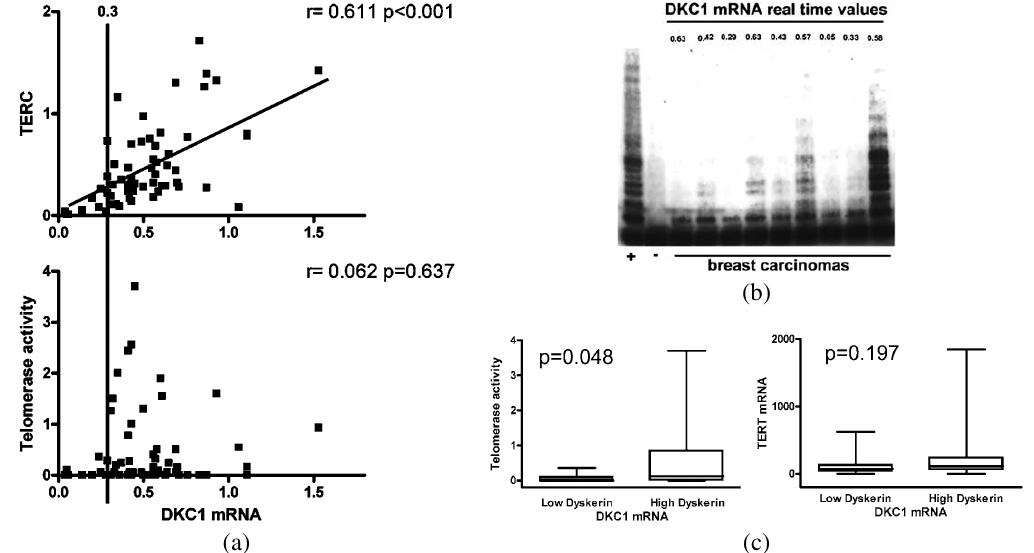
Fig. 1. Relationship between dyskerin expression and TERC, TERT and telomerase activity in breast carcinomas. Dyskerin mRNA levels proved strictly related to TERC levels (a, upper panel). No linear relationship was found when comparing dyskerin mRNA expression and telomerase activity, though a subset of tumours characterized by reduced dyskerin expression (relative expression < 0.3) were characterized by a significant reduction in telomerase activity ( p = 0 . 048; (a) lower panel, (b, c) left panel) as compared to tumours with higher dyskerin expression ( > 0.3). (b) Evaluation of telomerase activity by TRAP analysis. The relative expression of DKC1 mRNA is also shown. “ + ” telomerase positive control; “ − ” heat inactivated telomerase negative control. (c) Box and whiskers graph of telomerase activity and TERT relative expression obtained in samples with low ( < 0.3) and high ( > 0.3) dyskerin expression. While telomerase activity resulted significantly reduced in tumor expressing low dyskerin levels ( p = 0 . 048), no significant difference was found when comparing TERT expression of the two groups ( p = 0 .